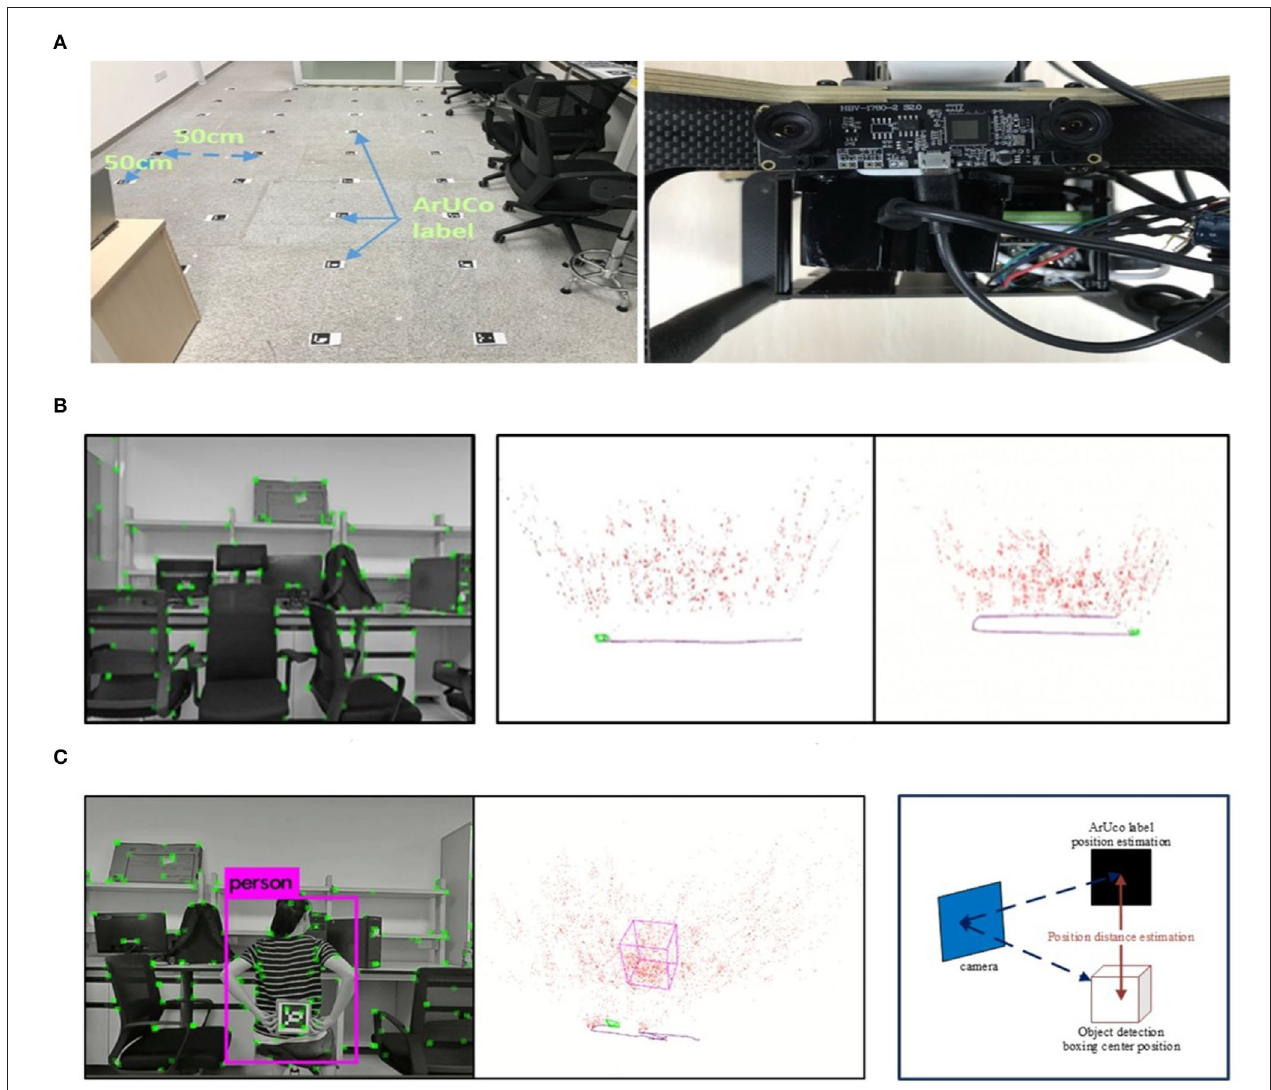
FIGURE 12 | The illustration of the indoor test procedure and results. (A) The experimental scene and binocular camera. (B) The tracking screenshot in the actual scene. (C) (Left): The object detection in the actual scene; (Right): Comparison of object position